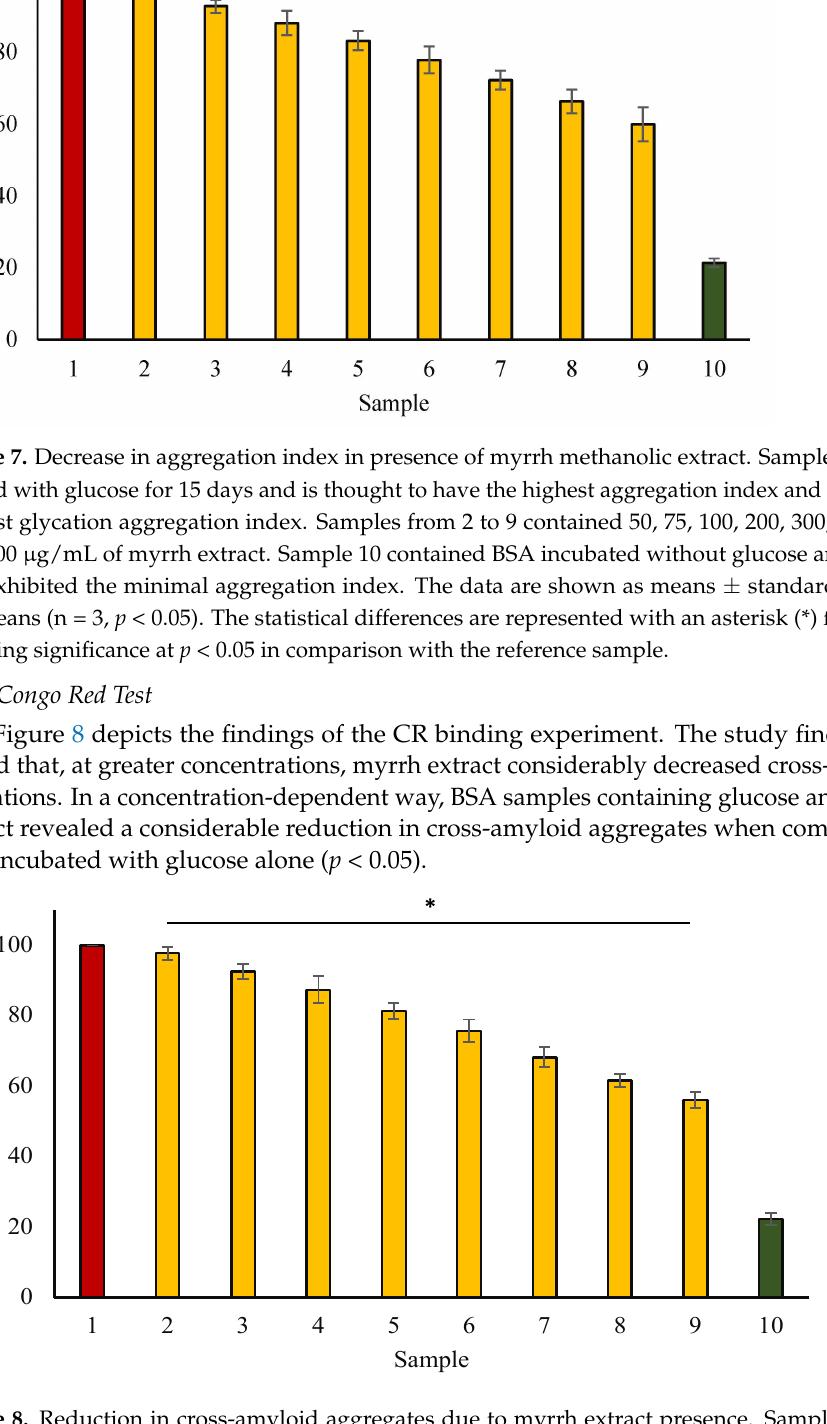
Figure 8. Reduction in cross-amyloid aggregates due to myrrh extract presence. Sample 1 refers to BSA treated with glucose for 15 days, and therefore is believed to have 100% structural changes. Samples 2–9 included 50, 75, 100, 200, 300, 400, 500, and 600 g/mL of myrrh, and cross-amyloid aggregates were found to decline as myrrh content increased. Sample 10 (green column) included BSA that had not been mixed with glucose or extract and had the fewest cross-amyloid aggregates. The data are shown as means ± standard error of the means (n = 3, p < 0.05). The statistical differences are represented with an asterisk (*) for myrrh denoting significance at p < 0.05 in comparison with the reference sample.